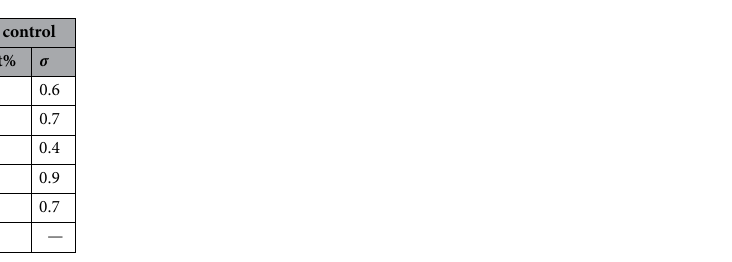
Table 2. Results of the elemental analysis by energy-dispersive